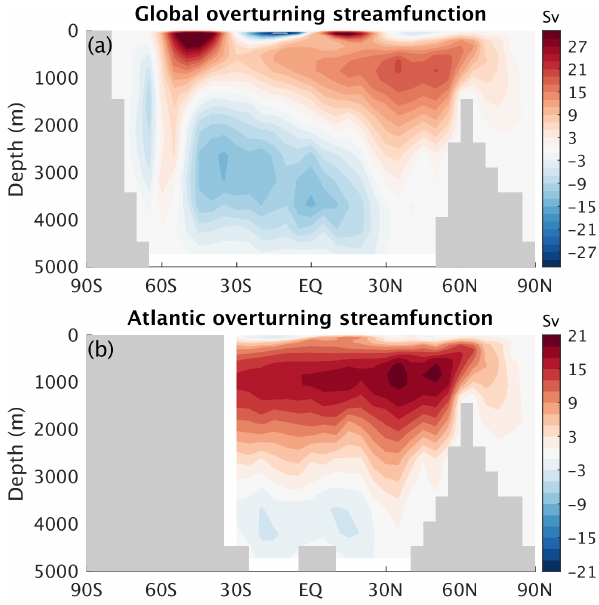
Figure 13. Maximum monthly mixed-layer depth simulated by CLIMBER-X (a) compared to ECCOv4 reanalysis (ECCO Consor- tium et al., 2021) (b)